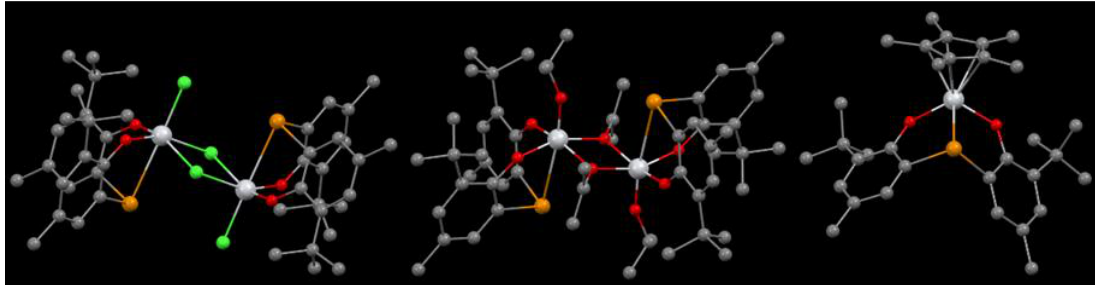
Figure 3. Tellurium-bridged diphenolate titanium complexes [8].